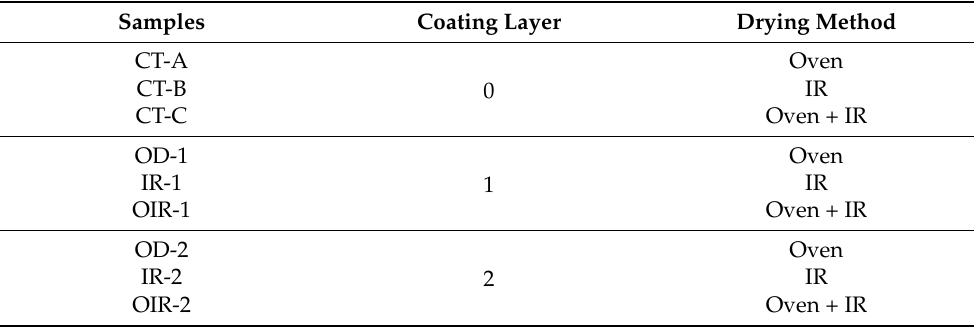
Table 2. Design of coating trial with a defined number of layers and drying regimes. Trials with one layer of CMC are indicated by OD-1, IR-1, and OIR-1, while trials with two CMC layers are indicated by OD-2, IR-2, and OIR-2. CT-A, CT-B, and CT-C are the uncoated samples. Samples Coating Layer Drying